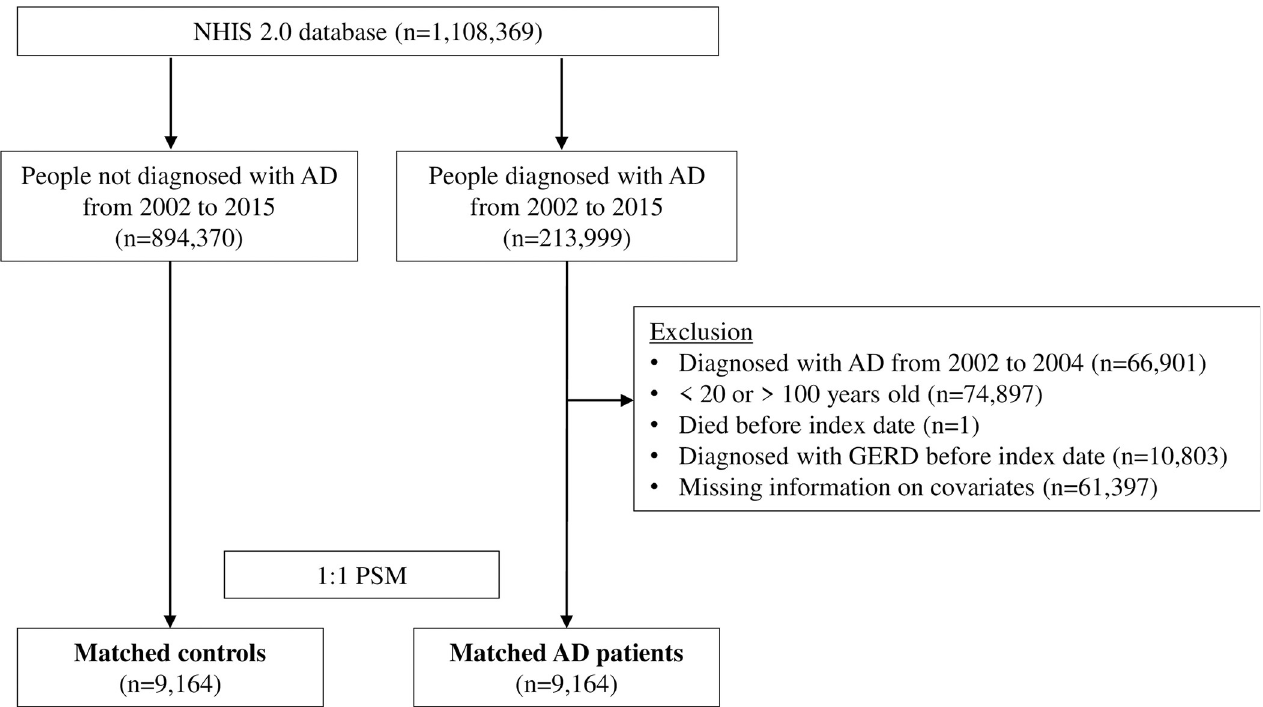
Fig 1. Flow diagram of the study population. AD, atopic dermatitis; GERD, gastroesophageal reflux disease; NHIS, National Health Insurance Service; PSM, propensity score matching.